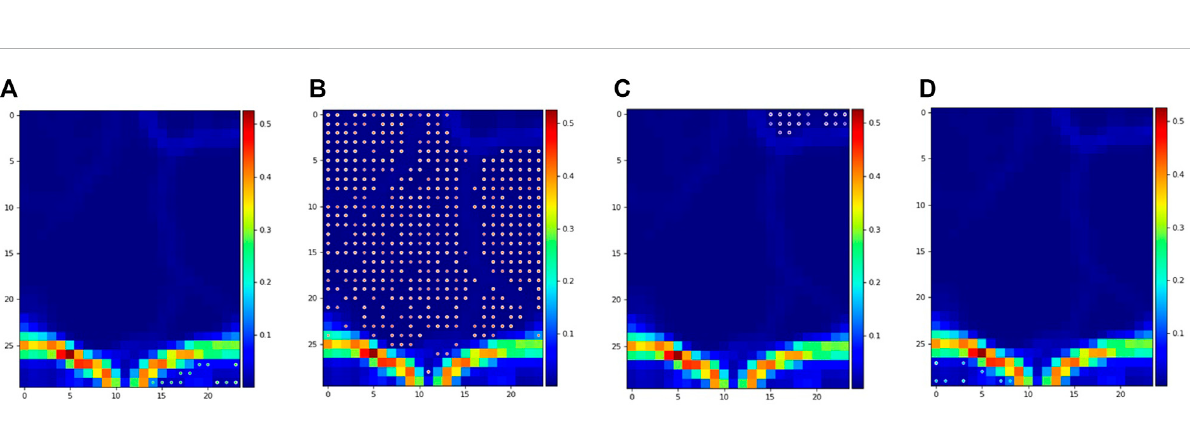
FIGURE 10 Projection of clusters over the self-organizing map for the pyrolysis reactor dataset using No DR-K-means (4